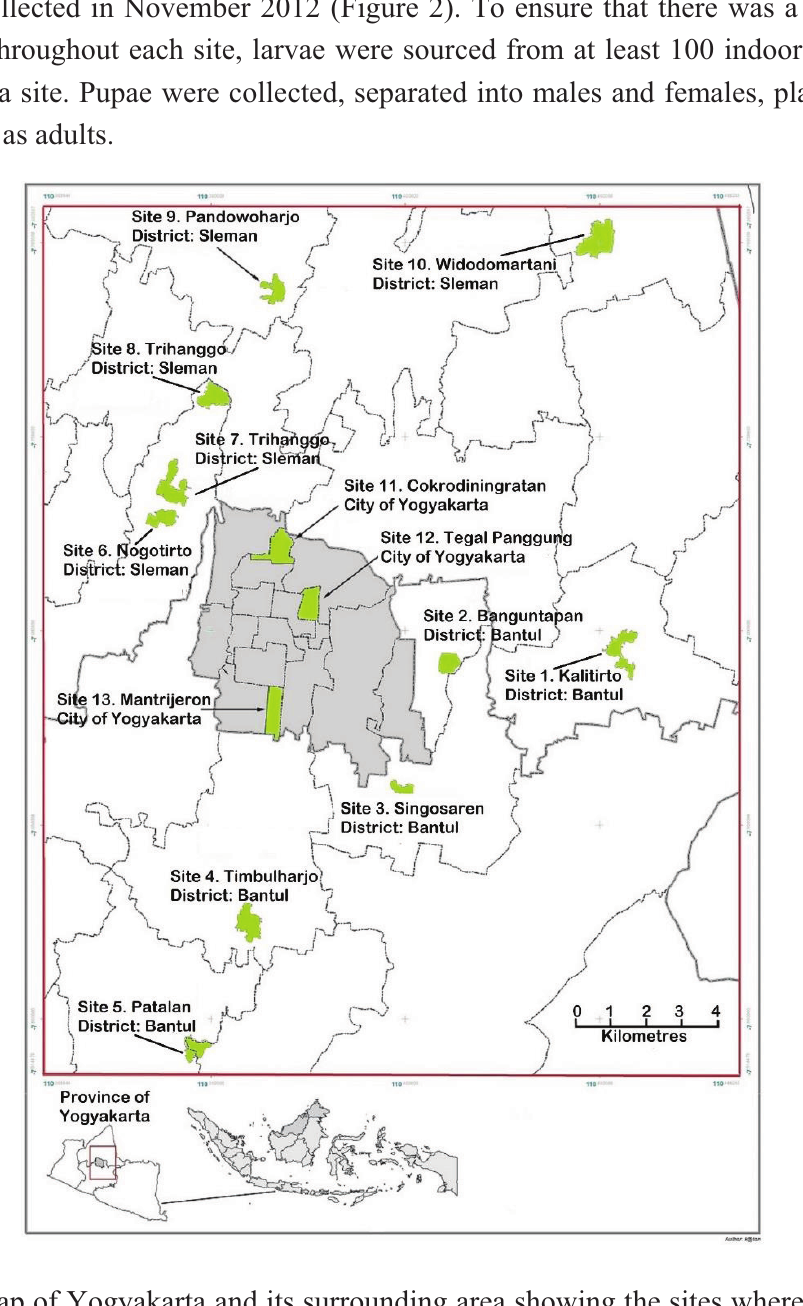
Figure 2. Map of Yogyakarta and its surrounding area showing the sites where samples of Aedes aegypti were